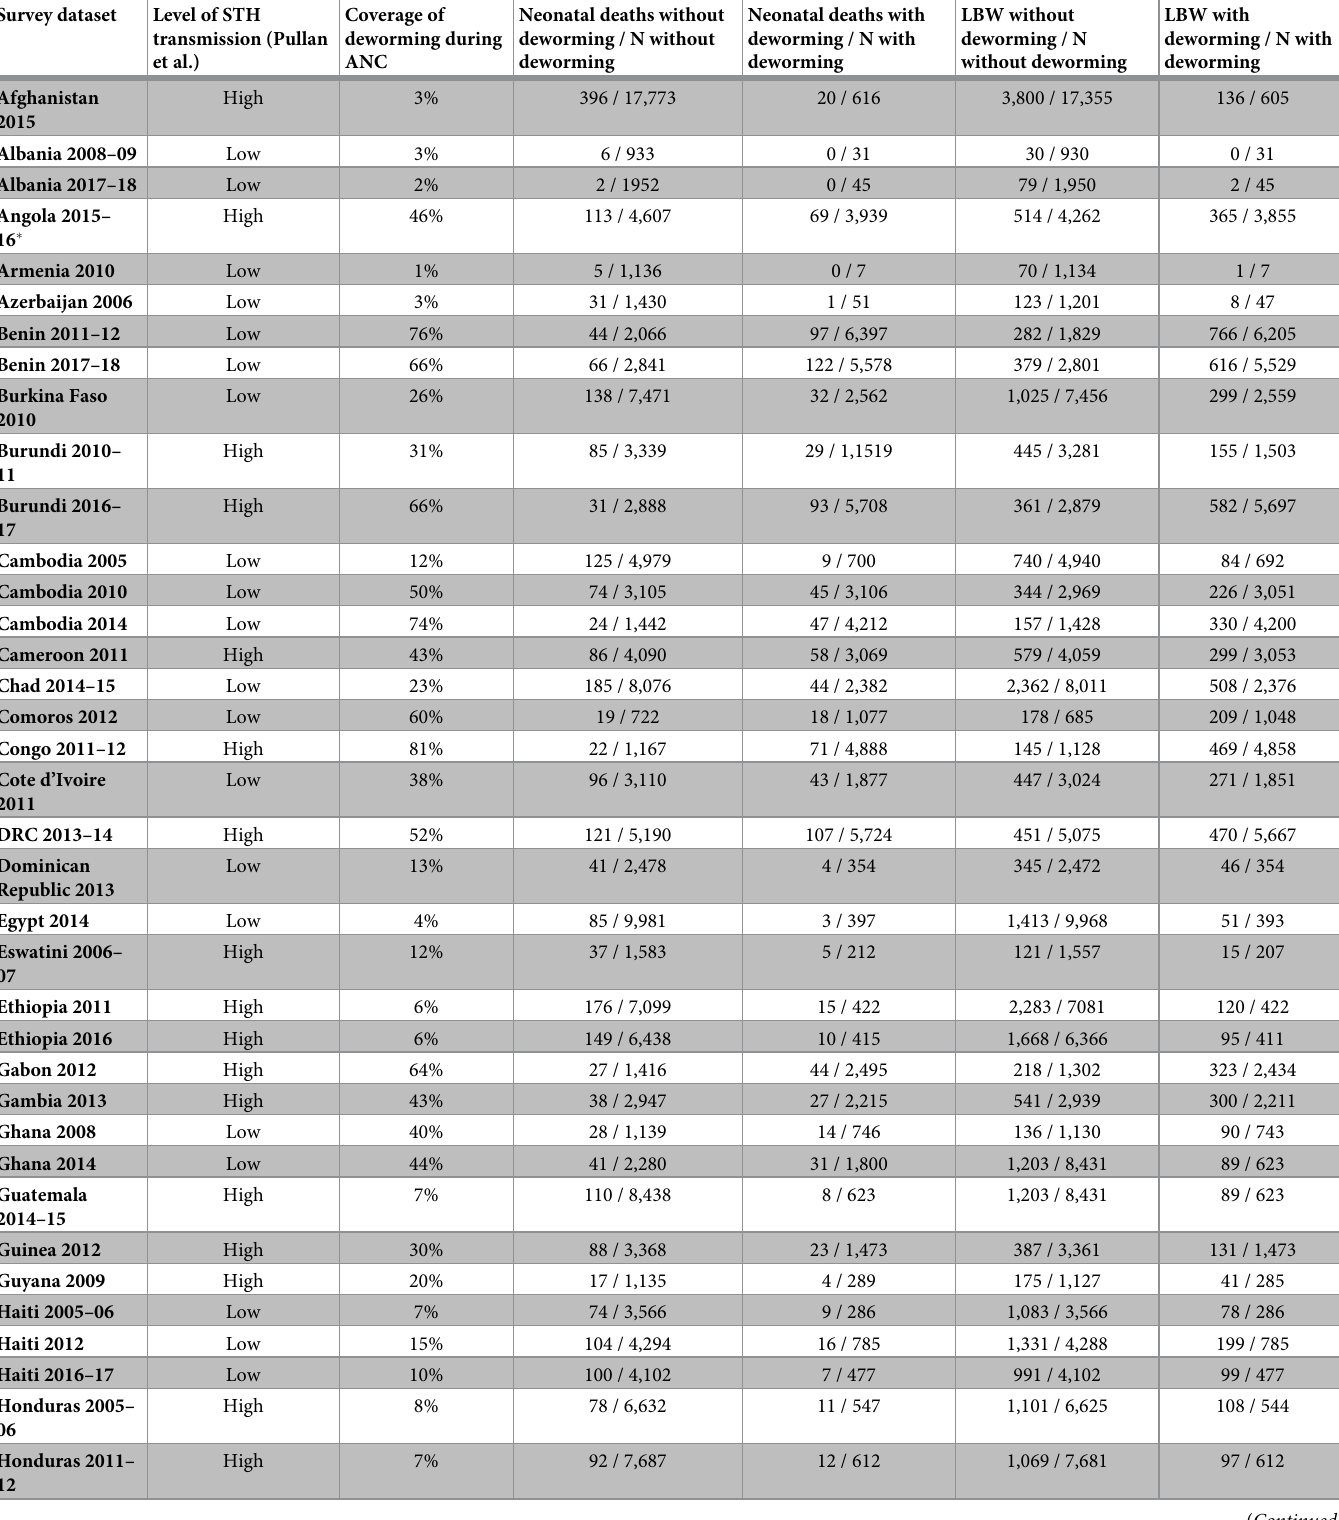
Table 1. Number of women receiving deworming medicine during routine ANC and birth outcomes. Survey